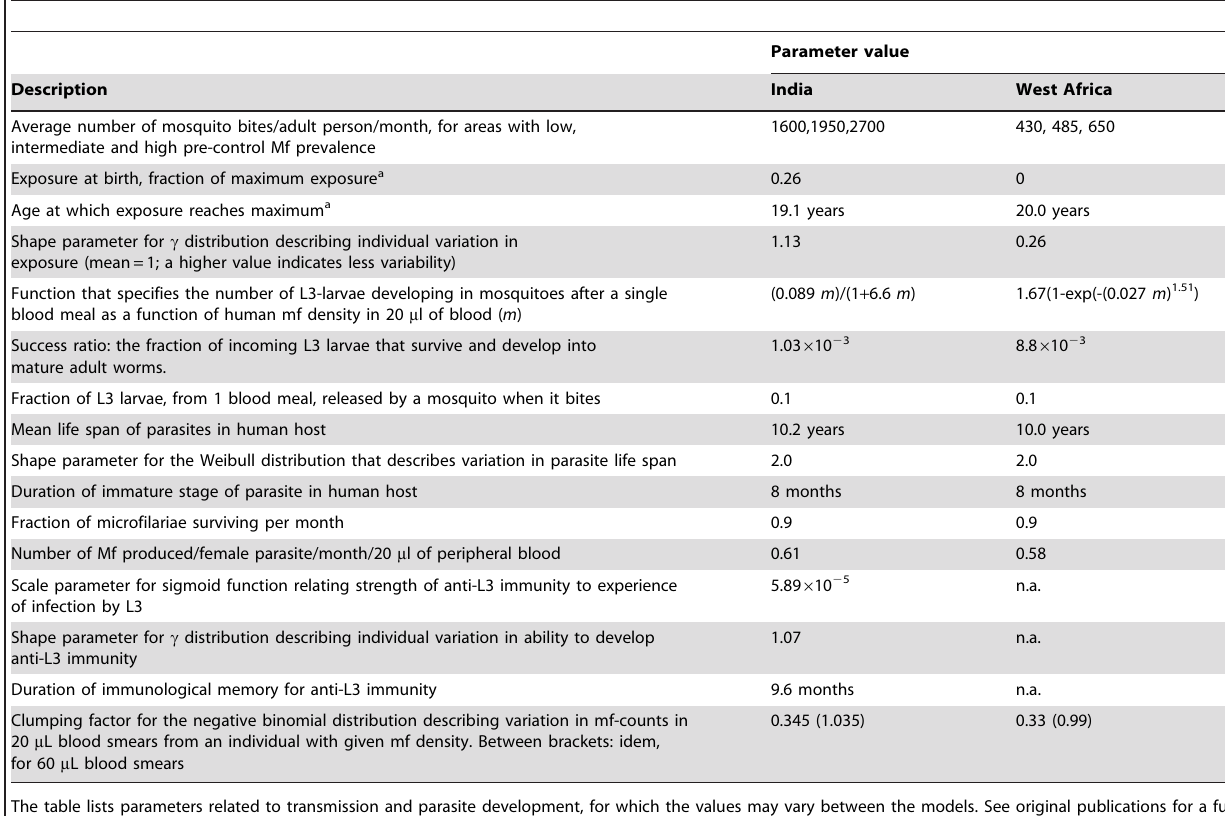
Table 1. Values of LYMFASIM parameters in models for India and West